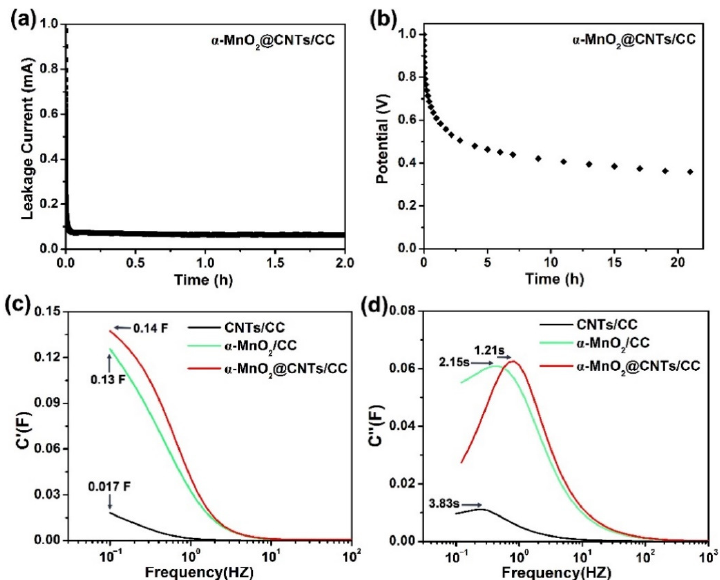
Figure 6. ( a ) Self-discharging and ( b ) leakage currents in self-discharging of the α -MnO 2 @CNTs/CC electrode in 1 M Na 2 SO 4 ; Evolution of the ( c ) real part and ( d ) imaginary capacitance vs. frequency for CNTs/CC, α -MnO 2 /CC, and α -MnO 2 @CNTs/CC electrodes in 1 M Na 2 SO 4 .